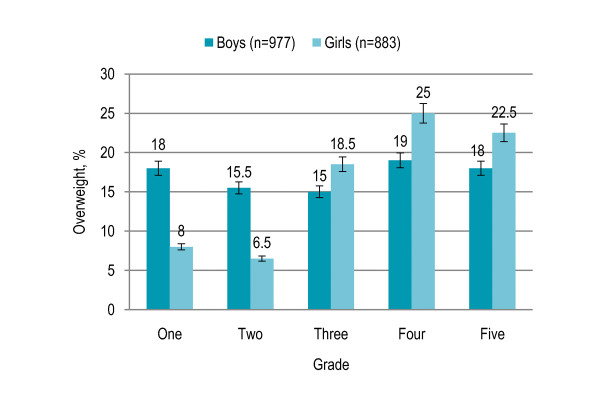
Grade- and gender- specific prevalence (with confidence interval bars) of overweight among primary school children in Lahore, Pakistan (n = 1860)